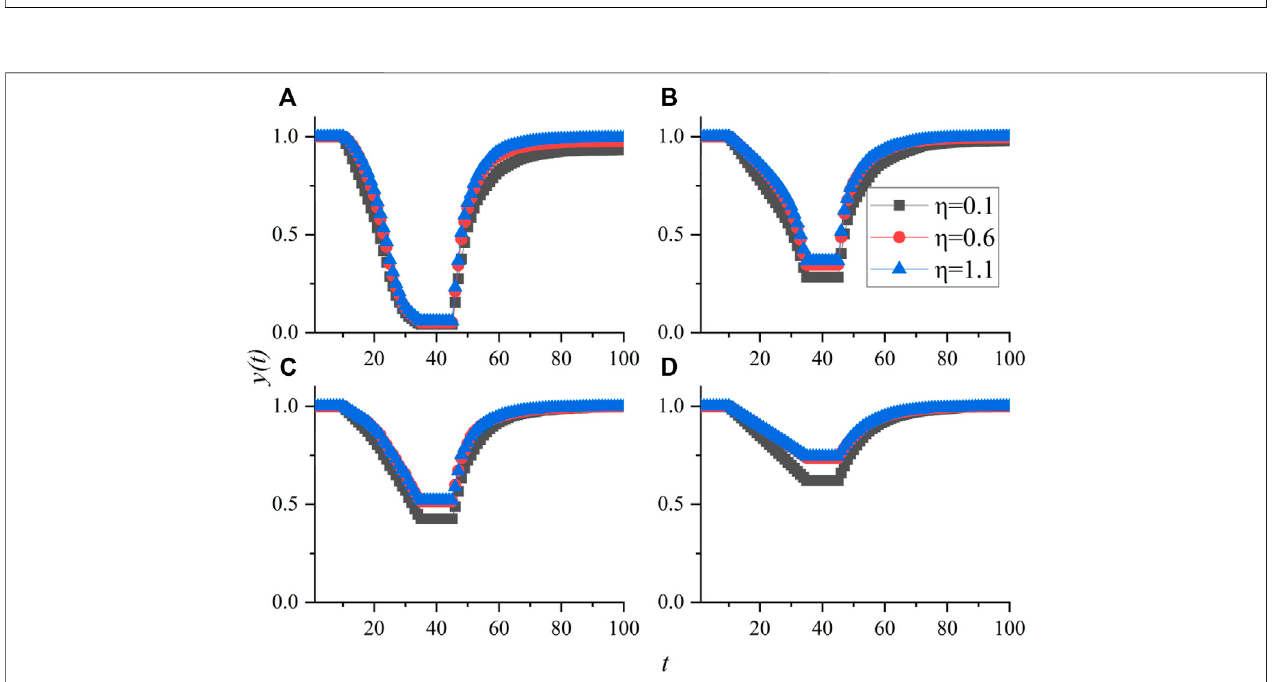
FIGURE 7 | In fl uence of parameter η on the resilience of the four networks. To re fl ect the difference, η is set to 0.1, 0.6, and 1.1, respectively. In addition, the remaining parameters β , and p are set to 0.1.